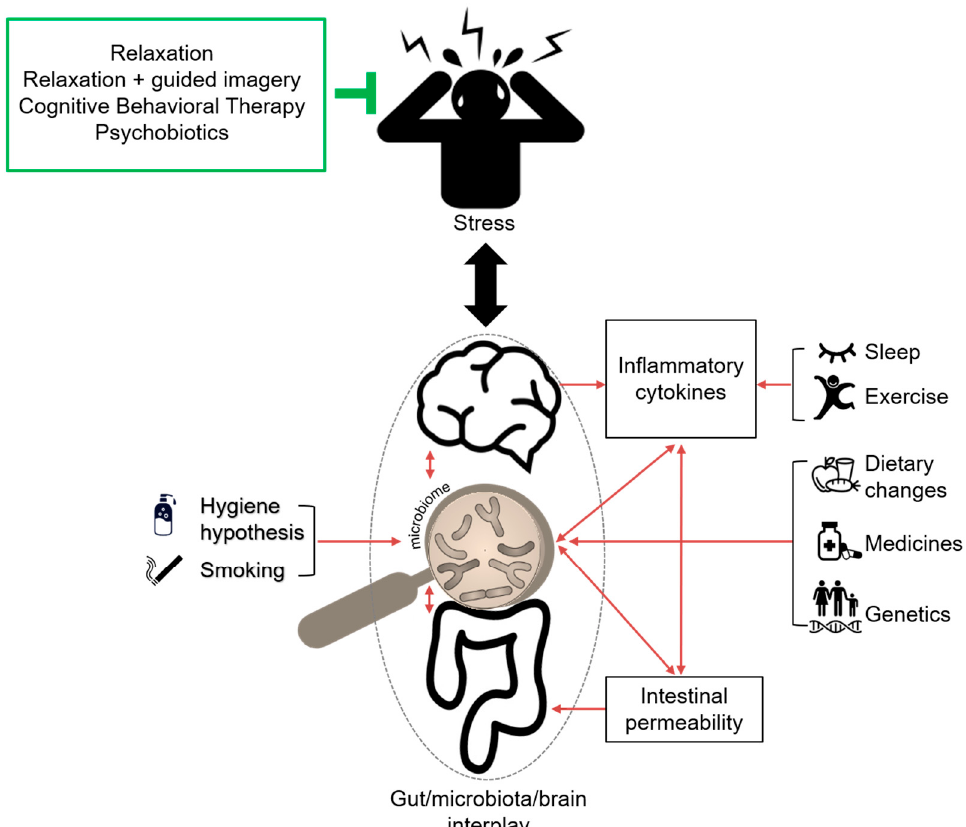
Figure 1. The gut/microbiota/brain interplay and its interactions upon exposure to stress. Under conditions of psychological stress including lack of sleep and physical inactivity, the brain (HPA axis) stimulates the production of pro-inflammatory cytokines. This can result in increased intestinal permeability and altered gut microbiota. In addition, fat- and sugar-enriched foods, long-term usage of medicines, as well as genetic predisposition can directly affect the gut microbiota composition, and subsequently, intestinal permeability. Furthermore, personal habits, such as hygiene and smoking, can also have an impact on the gut microbiome. Altogether, the multitude of stress-related factors can perturb the gut/microbiota/brain interplay, which contributes to the development of IBD. Relevantly, several stress management techniques have been proven to greatly alleviate IBD symptoms and improve the quality of life of IBD patients. Given that the exact underlying mechanisms in the context of IBD are not yet fully understood, therapeutic options aimed at improving stress management deserve further investigation.